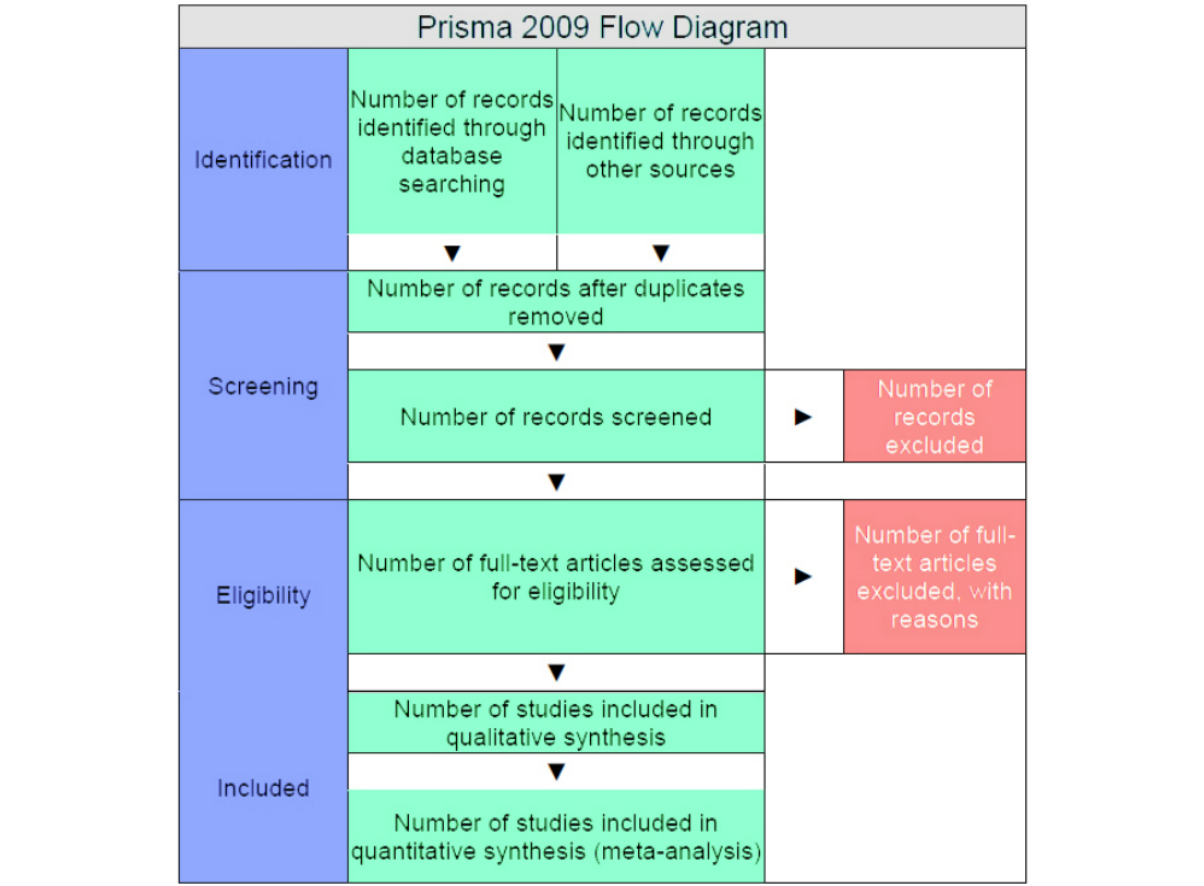
Figure 1. Flow diagram according to